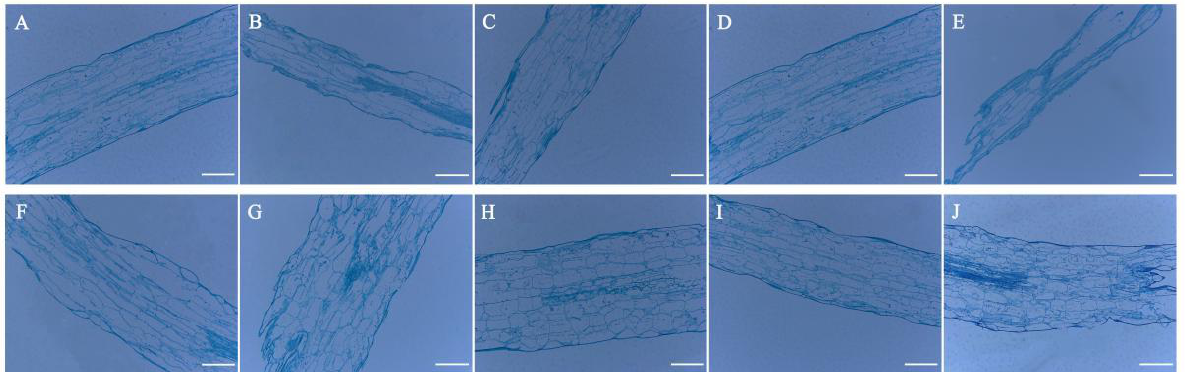
Figure 7. Effects of 24-EBL/DCB treatments on the anatomical structure of celery hypocotyl. ( A – E ) The anatomical structure of celery hypocotyl treated with 0, 1.04 × 10 −5 , 2.08 × 10 −5 , 4.16 × 10 −5 and 8.32 × 10 −5 mol/L 24-EBL, respectively. ( F – J ) The anatomical structure of celery hypocotyl treated with 0, 2.33 × 10 −4 , 3.49 × 10 −4 , 4.65 × 10 −4 and 5.81 × 10 −4 mol/L DCB, respectively. Scale bars = 100 μm.